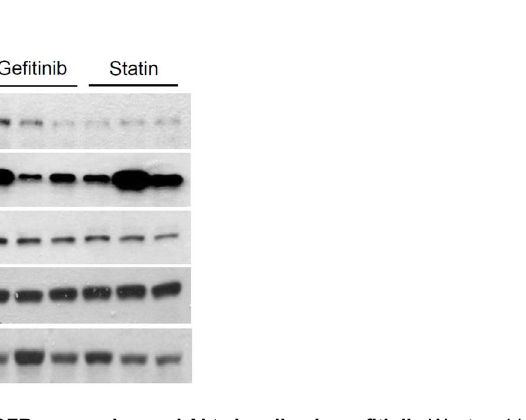
Fig. 5. Regulation of EGFR expression and Akt signaling by gefitinib. Western blotting analysis of EGFR, pEGFR, Akt and pAkt levels after gifitinib or statin treatment. ß-actin is included as a lading control.